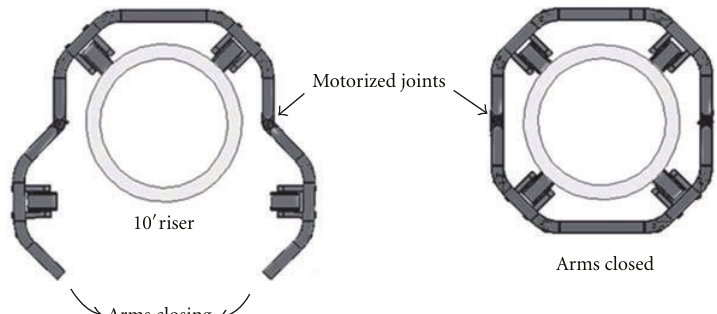
Figure 2: Transversal view of the robot frame showing how it attaches the riser, by opening and closing its motorized arms. The polymeric free wheels that e ff ectively touch the riser surface are also shown.